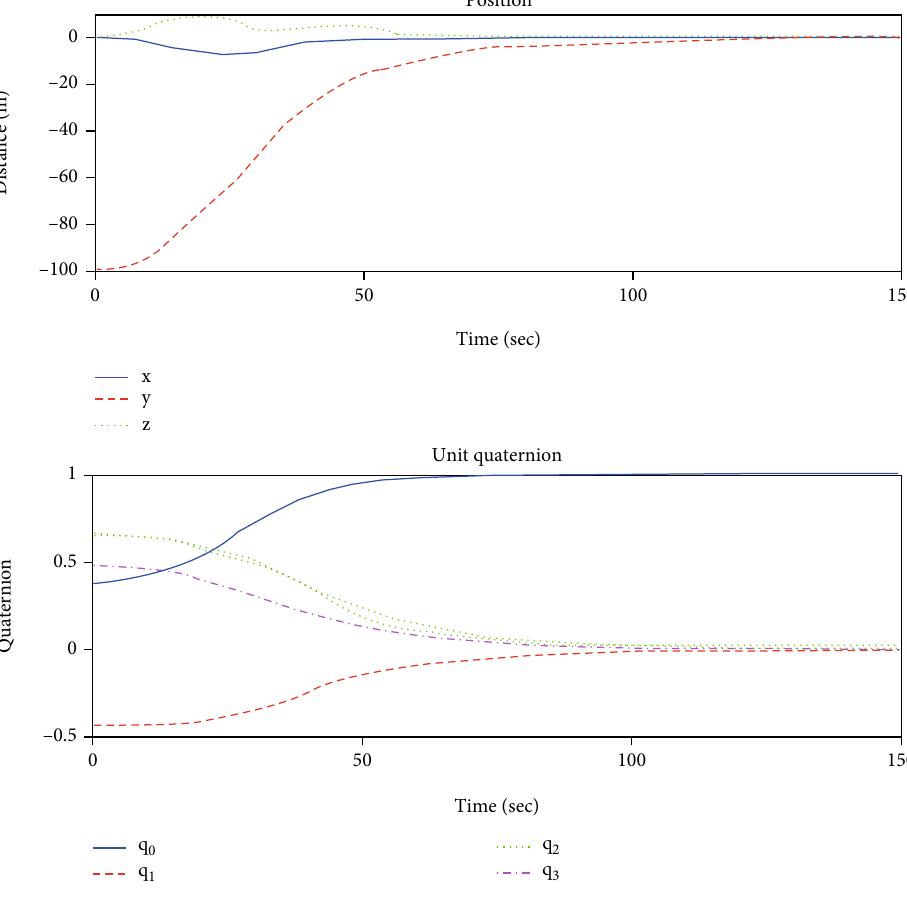
Figure 6: Time histories for the position and attitude of chaser satellite in target body fi xed frame.